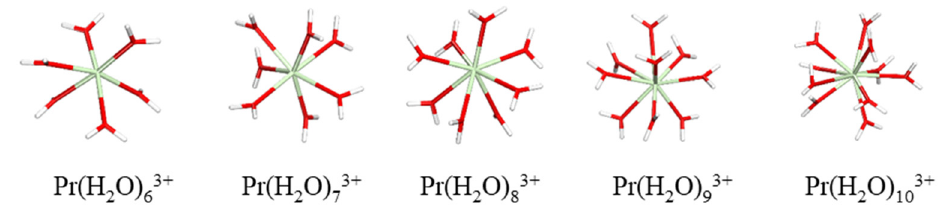
Figure 1. The equilibrium geometries of [Pr(H 2 O) 6 − 10 ] 3+ from periodic DFT calculations.